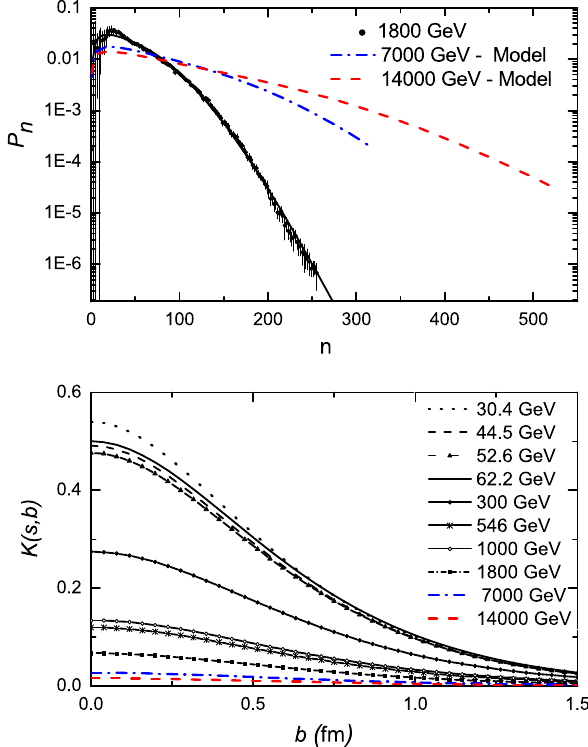
Fig. 9 Top panel: Theoretical results in full phase space P n ( s ) at 7 and 14 TeV, Eqs. (16) and (17). Experimental data of the P n ( s ) at 1800 GeV added to comparison. The another panel shows predictions of K ( s ) , Eq.